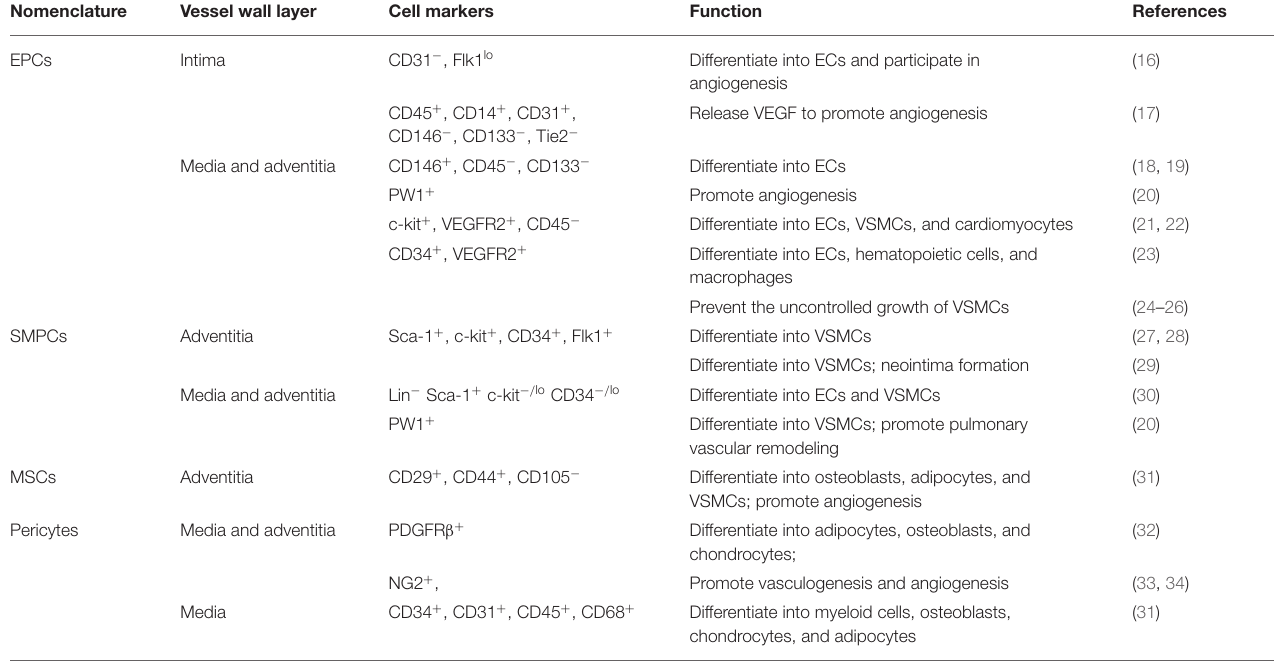
TABLE 1 | Distribution and function of vascular wall stem cells in three layers of blood